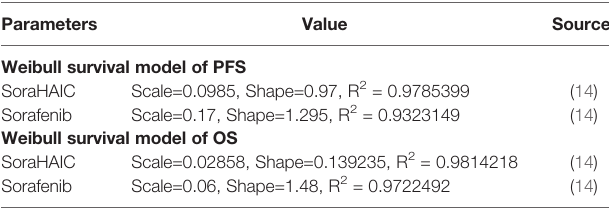
TABLE 1 | Relevant parameters of survival distribution.